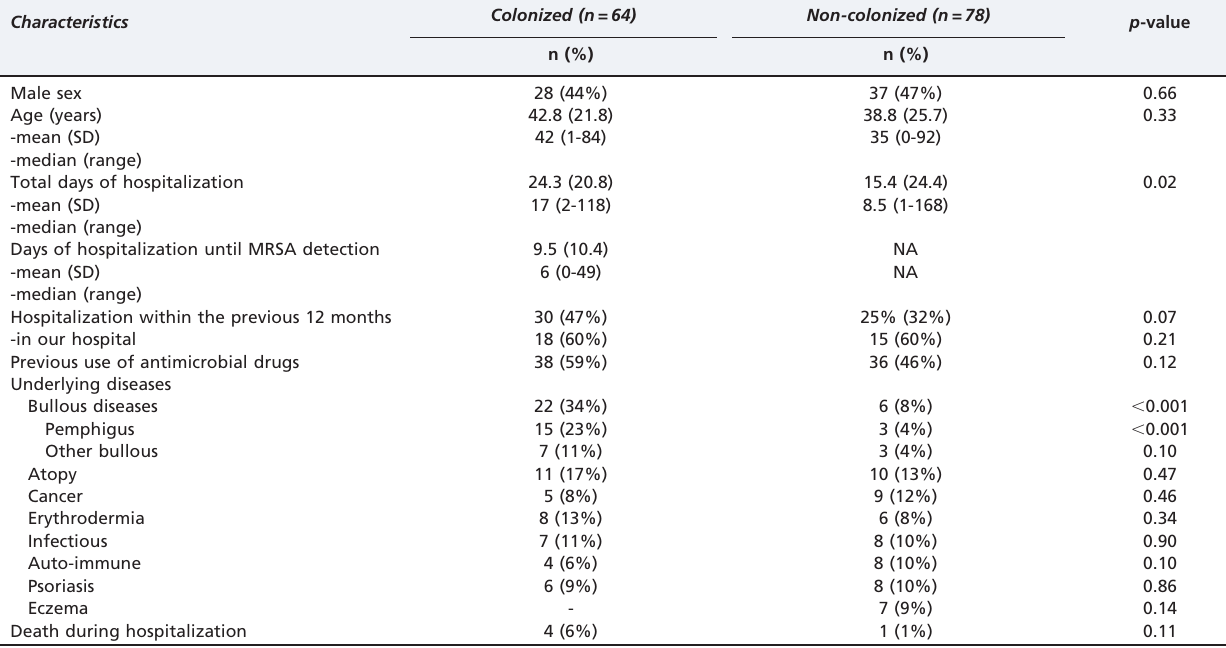
Table 1 - Characteristics of MRSA-colonized patients and non-colonized patients in the dermatology unit over a 6- month